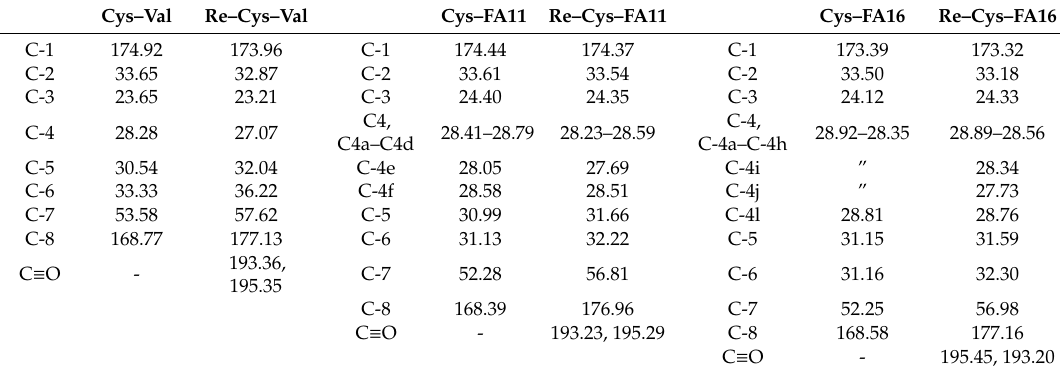
Table 2. 13 C NMR chemical shift assignments for ligands Cys–Val , Cys–FA11 , Cys–FA16 and complexes. Re–Cys–Val , Re–Cys–FA11 , Re–Cys–FA16 in DMSO- d 6 at 25 ◦ C. The numbering of the atoms is given in Scheme